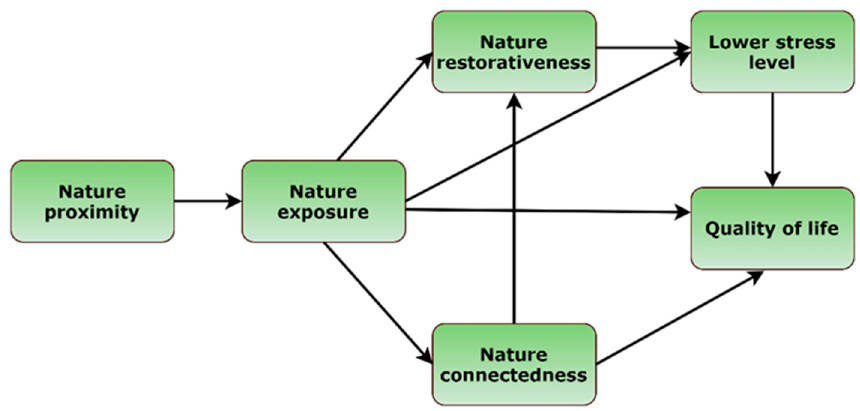
Figure 1. Theoretical model of the mediating effect of nature restorativeness, stress level, and nature connectedness in the association between nature exposure and quality of life.